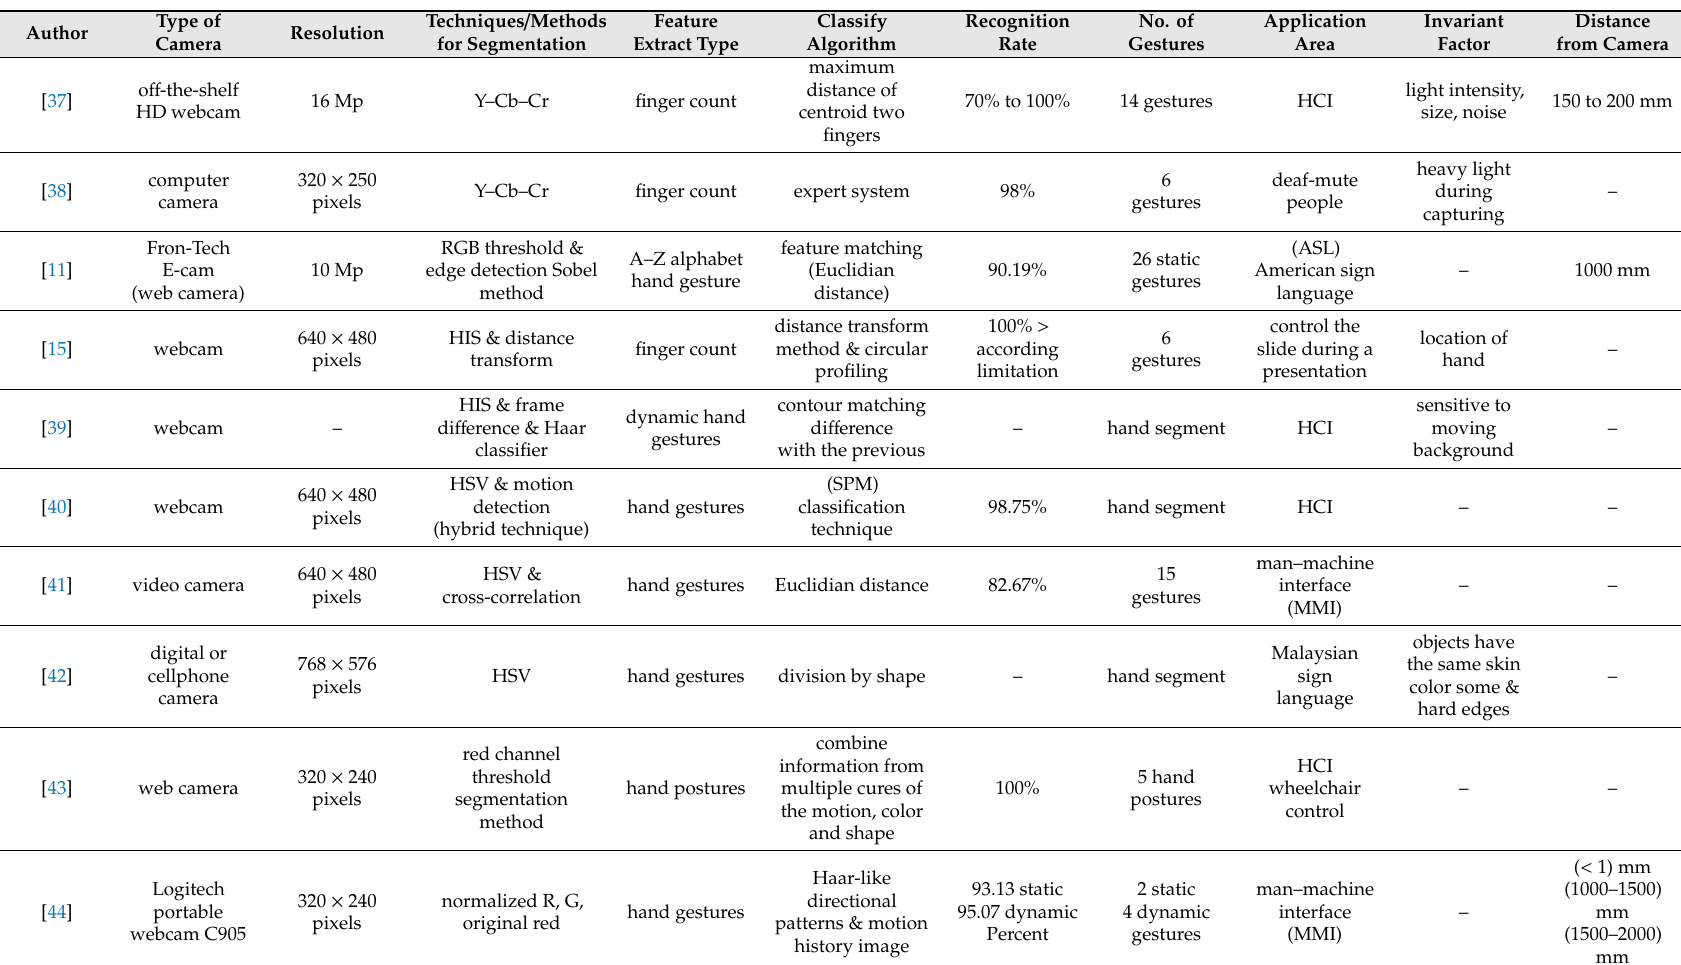
Table 1. Set of research papers that have used skin color detection for hand gesture and finger counting